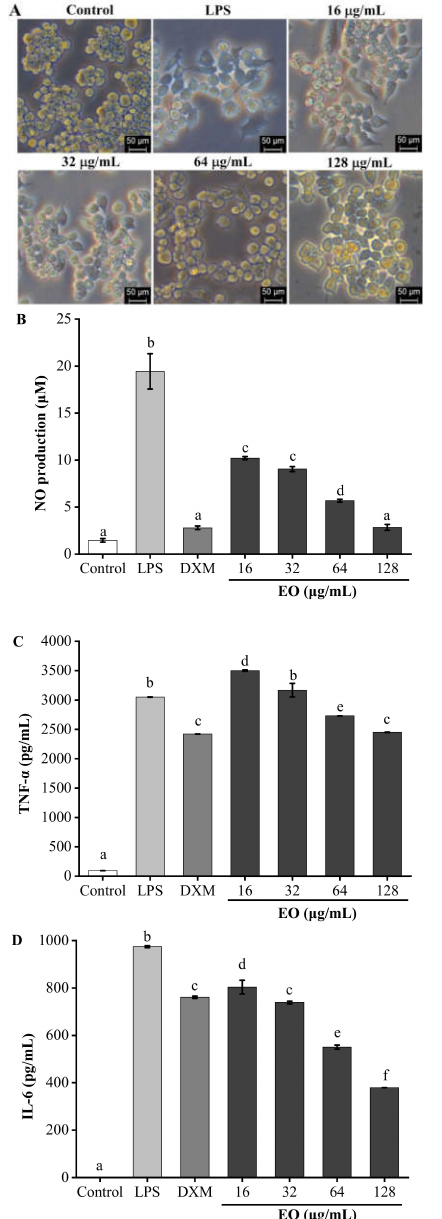
Figure 3. Effects of R. beesianus rhizome EO on the lipopolysaccharide (LPS)-induced morphology (200 × ) ( A ), nitric oxide (NO) production ( B ), and secretion of tumor necrosis factor- α (TNF- α ) ( C ) and interleukin-6 (IL-6) ( D ) in RAW264.7 macrophages. ( A ) The RAW 264.7 macrophages were exposed to different EO concentrations and in the presence or absence of LPS (1 µ g/mL). After 24 h of incubation, the images of RAW 264.7 cells were taken. ( B ) The RAW 264.7 cells were exposed to different EO concentrations and stimulated with LPS. Dexamethasone (DXM, 20 µ g/mL) was used as a positive control. The accumulation of NO in the culture supernatants was assayed by the Griess reaction. ( C , D ) The RAW 264.7 cells were exposed to different EO concentrations and stimulated with LPS. The amount of TNF- α ( C ) and IL-6 ( D ) was determined using respective ELISA determination kits. The experiments were performed independently at least three times, and the data were expressed as the mean ± SD values. The different letters above bars indicate a significant difference ( p <